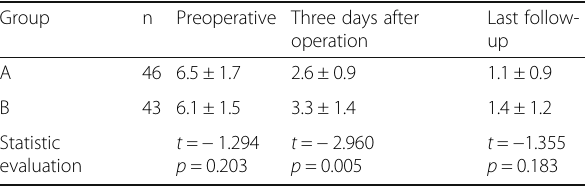
Table 3 Comparison of VAS scores at pre- and post-operation between 2 groups ð x (cid:3) s Þ Group n Preoperative Three days after